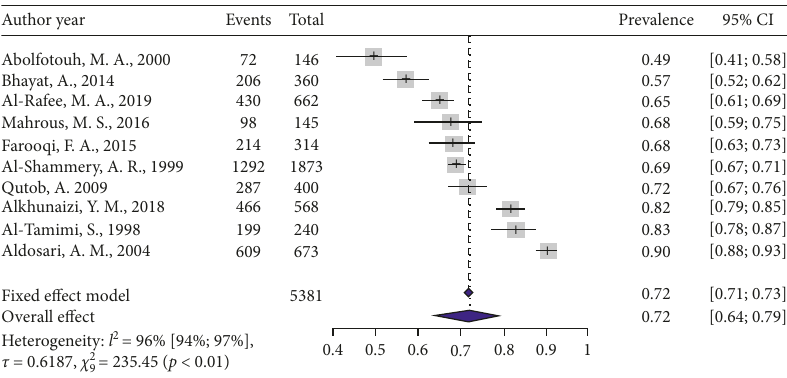
Figure 3: Pooled prevalence of dental caries among 12–15-year children.